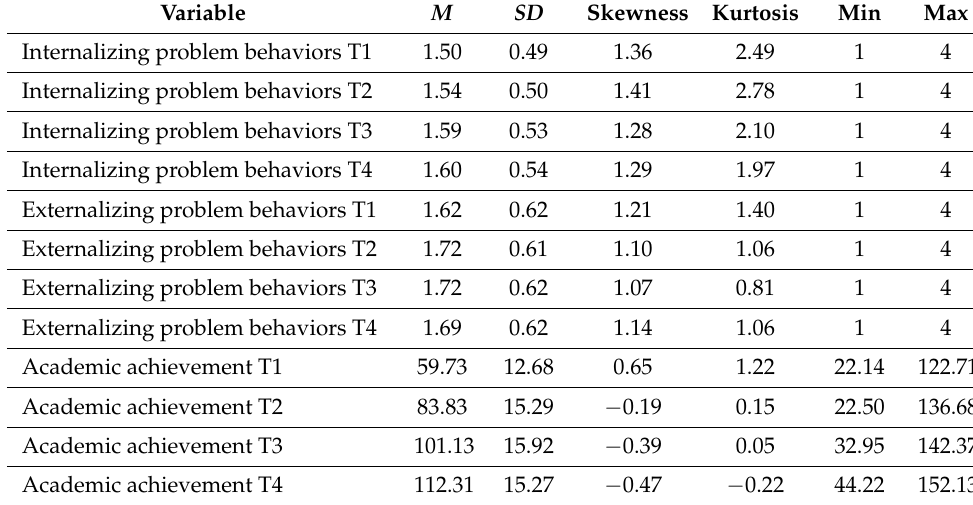
Table 1. Descriptive statistics of problem behaviors and academic performance